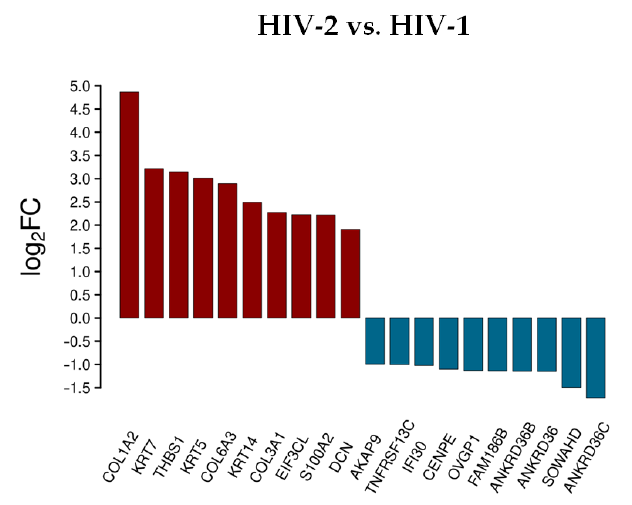
Figure 3. Differential expression of genes post HIV-2 transduction, compared to HIV-1. log 2 FC of the most up and downregulated protein genes detected from HIV-2 transduced cells.